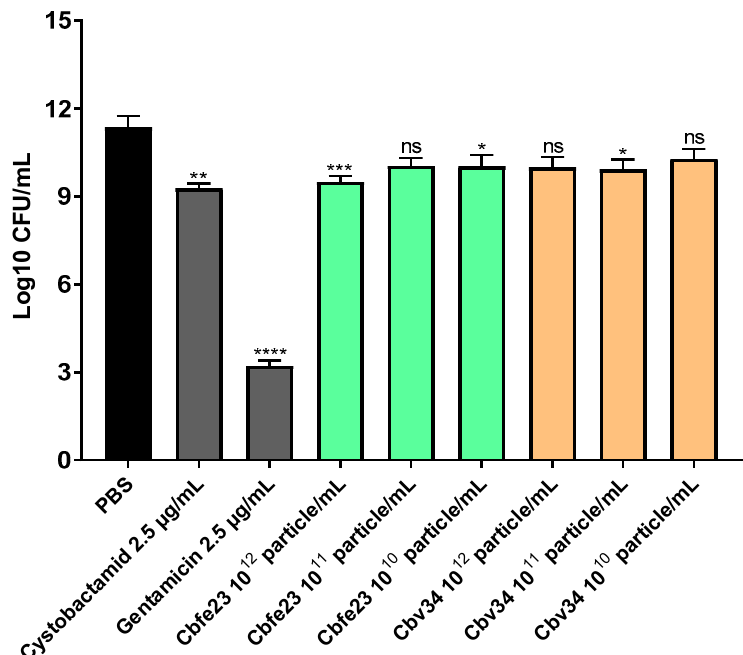
Figure 4. Antibacterial activity of Cbfe23 and Cbv34 OMVs against S. aureus strain Newman after 4 h of incubation at 37 °C. Mean ± SEM, n = 3. Significance was defined in comparison to the PBS control (black column) as * p -value < 0.05, *** p < 0.0005, **** p -value < 0.0001 and ns = not significant.